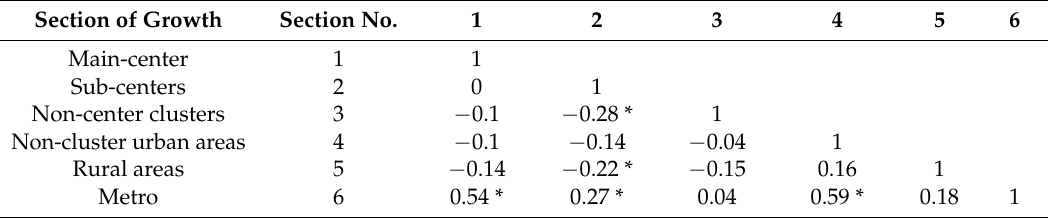
Table 3. Correlation matrix for growth in five submetro sections for midsize metros. Section of Growth